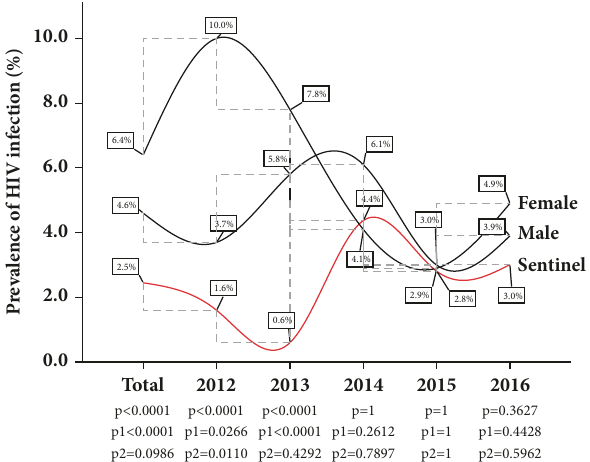
Figure 1: Year-on-year gender-specific HIV prevalence parallel analysis with the Sentinel Survey at the Ho Sentinel site: 𝑝 compares female donor and Sentinel, 𝑝1 compares male donor and Sentinel, and 𝑝2 compare female donor and male donor. 𝑝 is significant at 0.05.